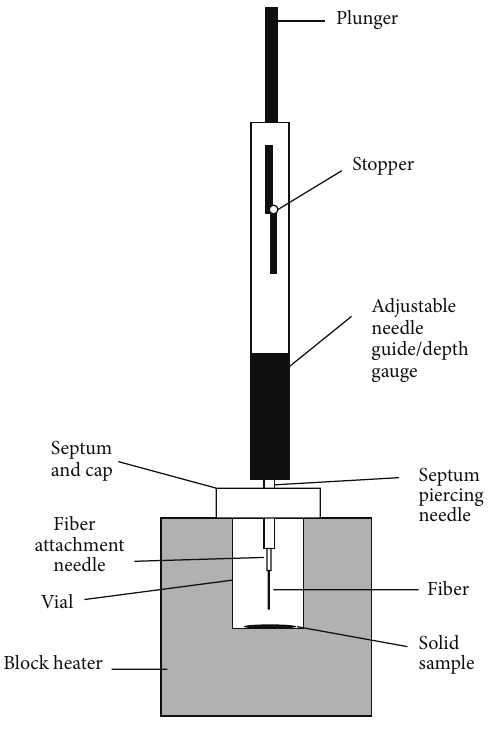
Figure 5: SPME high-temperature headspace sampling